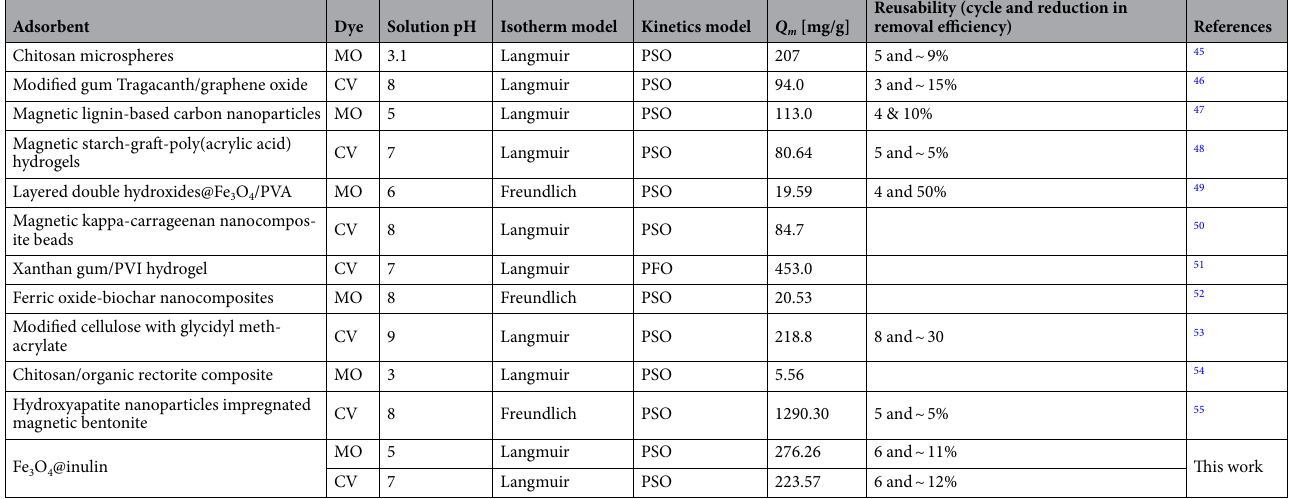
Table 4. Performance comparison of different bio-nano adsorbents for treating water contaminated with MO and CV dyes. PVA: ed poly (vinyl alcohol), PVI: poly (N-vinyl